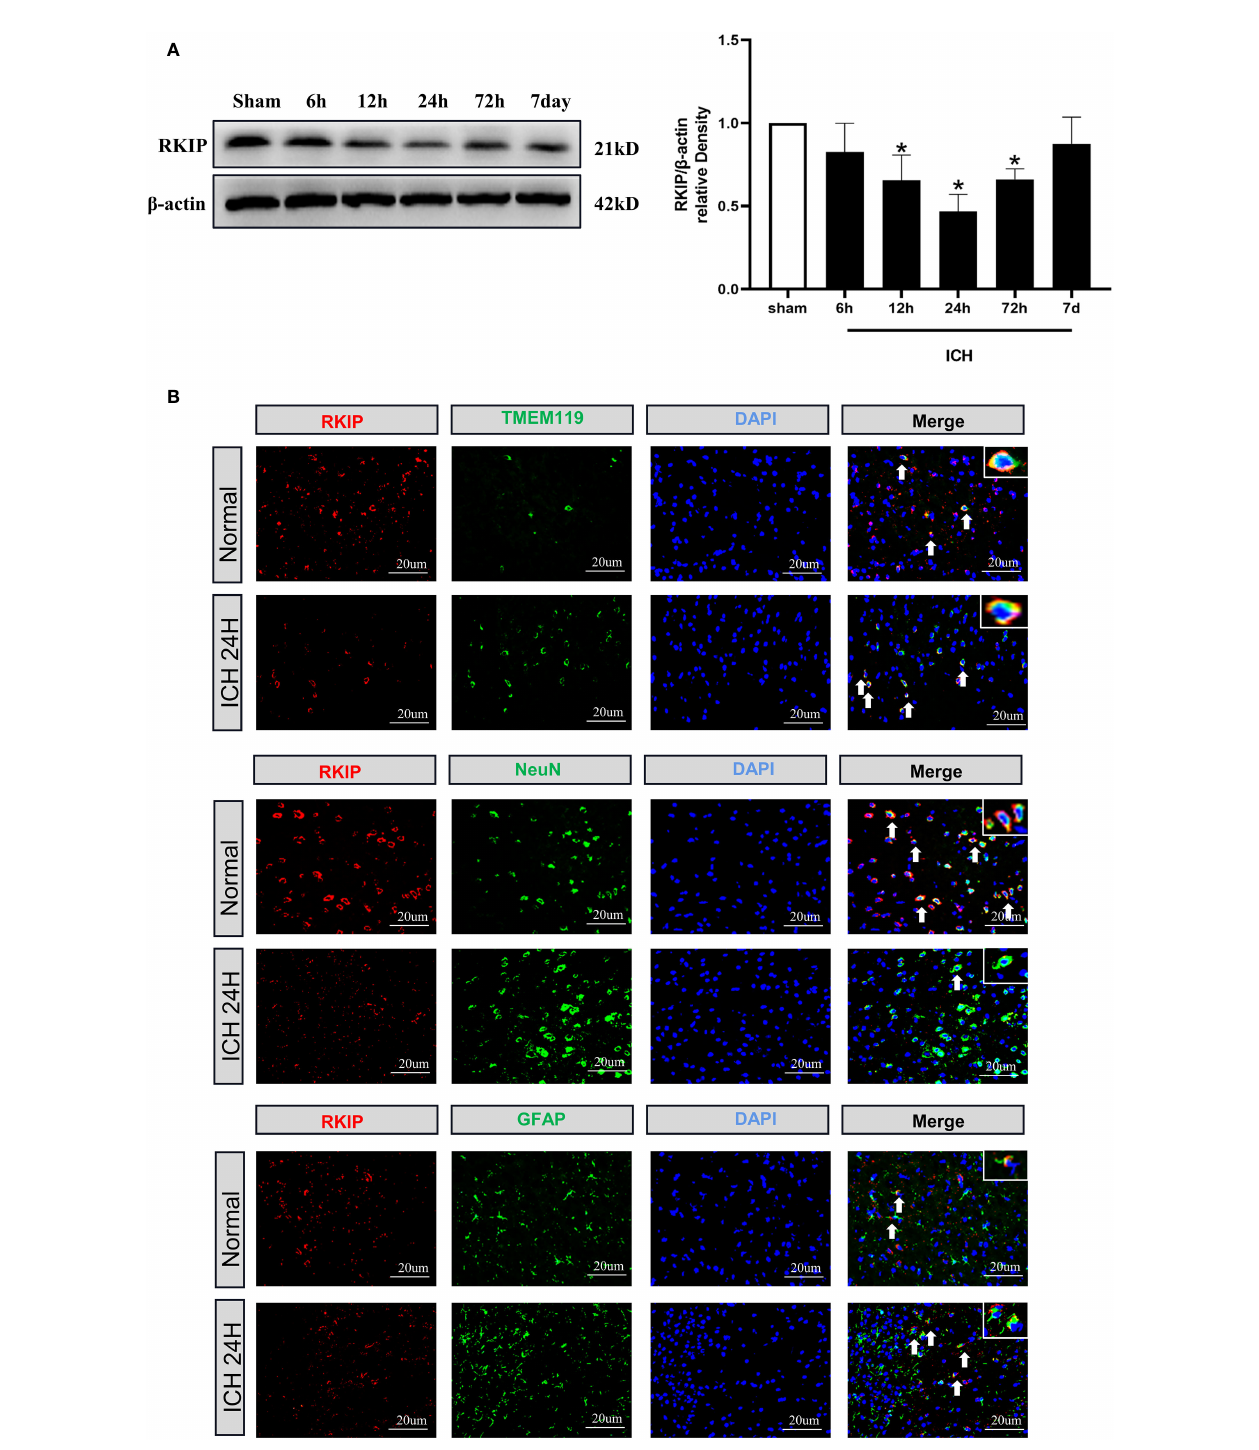
FIGURE 3 | The temporal expression and cellular localization of Rkip after ICH. (A) Representative Western blot band and quantitative analyses of Rkip time-dependent expression from the peri-hematoma tissue after ICH. n = 6 per group. *p < 0.05 vs. sham. (B) Representative images of double immuno fl uorescence staining showed that Rkip was co-localized with microglia (TMEM119), astrocytes (GFAP), and neurons (NeuN) separately at 24 h after ICH. Scale bar = 20 m m. n = 3 per